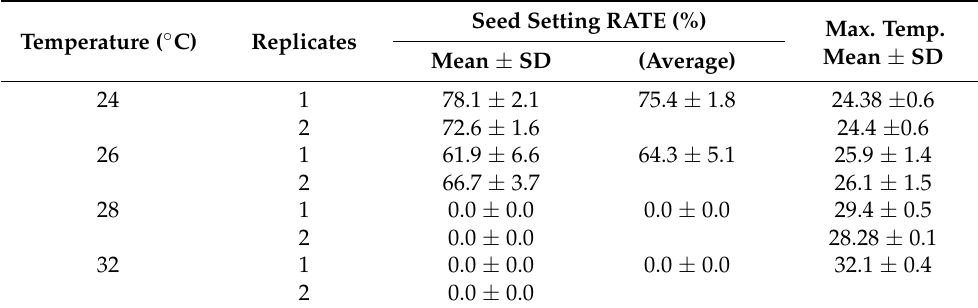
Table 1. Seed setting rate (%) of the thermosensitive genic male sterility (TGMS) line, IR68301S, grown under controlled